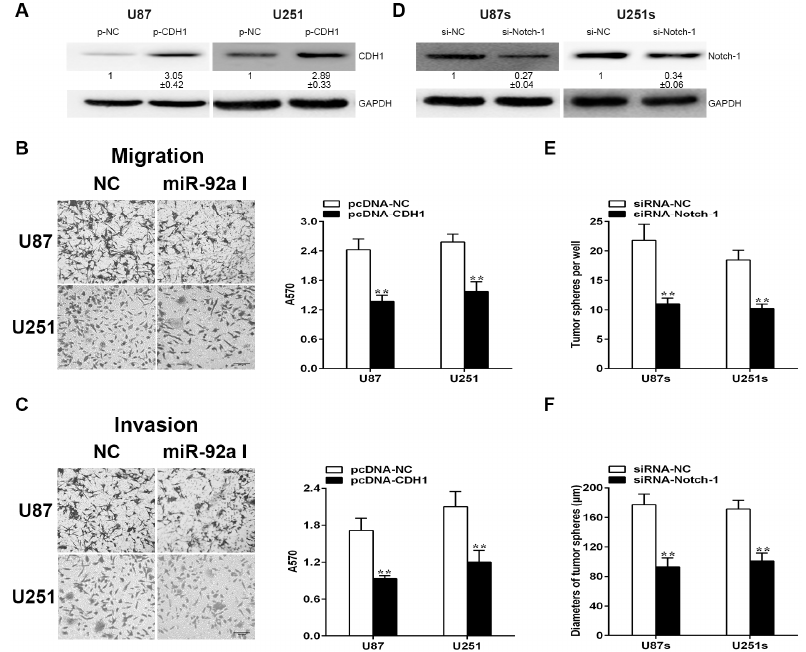
Figure 6. miR-92a-3p plays different roles in glioma cells and GSCs through targeting CDH1 and Notch-1, respectively. ( A ) Protein expressions of CDH1 in gliomas were measured by Western blotting; ( B , C ) Migration and invasion ability of glioma cells were detected through applying Transwell assay; ( D ) Protein expressions of Notch-1 in GSCs were qualified via Western blotting; ( E , F ) Stem-like traits of GSCs were evaluated by tumor sphere formation assay and diameters of GSCs. Each bar represents the mean of three independent experiments. ** indicates p < 0.01. Scale bar represents 200 µm.